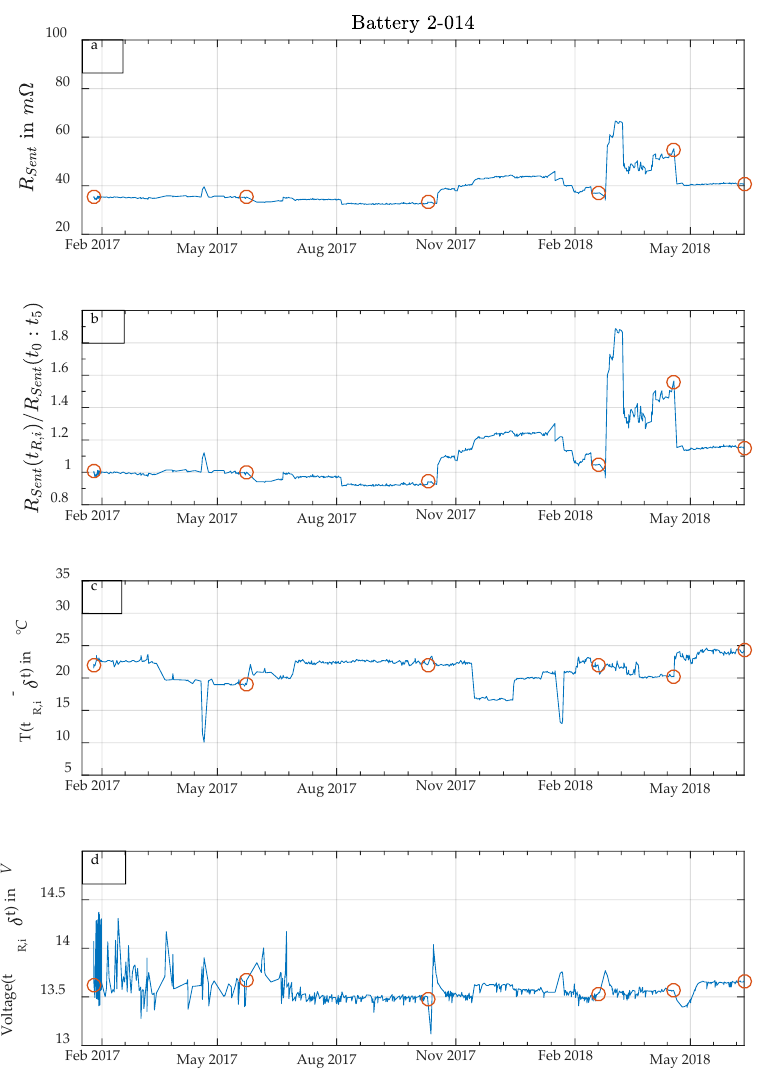
Figure 3. Example of continuous measurements for battery 2-014 of string 2. Red circles indicate the event of a check-up at the time step t R, i [ i = 0, ..., 5]. ( a ) Resistance by the LEM Sentinel 2 as an absolute value; ( b ) Resistance as a relative value based on the first 5 resistance measurements; ( c ) Temperature development of the battery with measurement before each check-up; ( d ) Voltage development of the battery with voltage measurements one time step before the resistance measurement in t R, i .